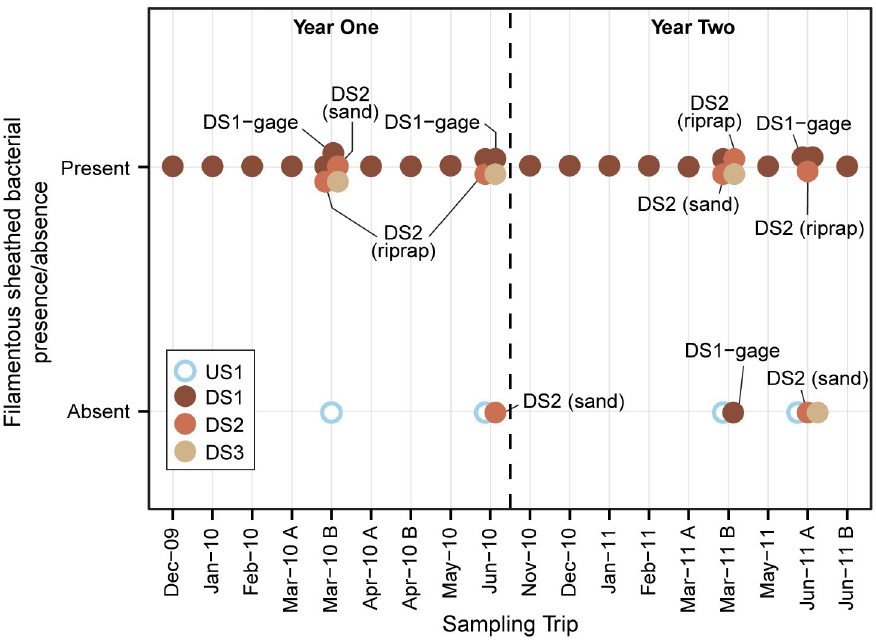
Fig 5. Microscopy assessments describing the presence or absence of filamentous sheathed bacteria such as Sphaerotilus , Leptothrix , and Thiothrix . Samples collected from main sites are not labeled; samples from sub-sites are identified with a text